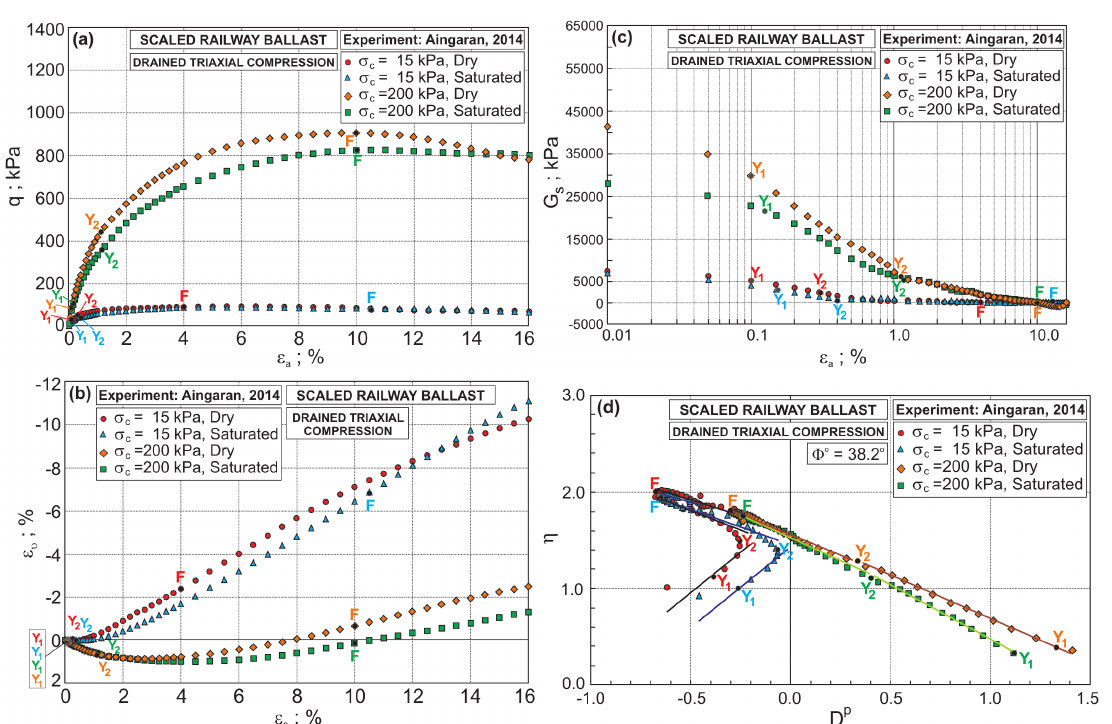
; (b) e – e ; (c) G – e ; and (d) h – D p . u a a s a